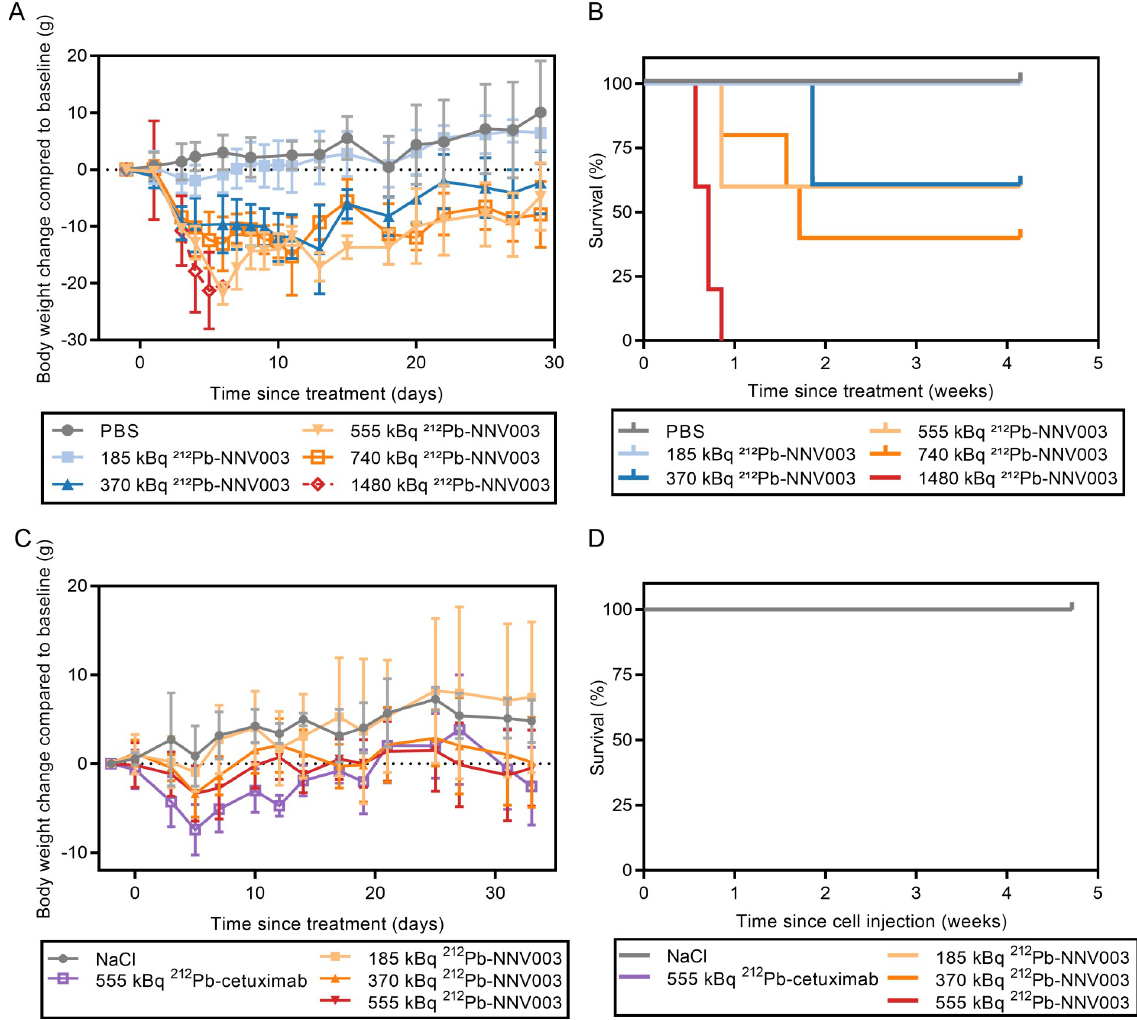
Fig 4. Acute toxicity of 212 Pb-NNV003. CB17 SCIDs were injected i.v. with increasing dose of 212 Pb-NNV003 or PBS. (A) Body weights (average of n = 5, error bars = SD) and (B) survival of the mice. R2G2 mice were injected with increasing dose of 212 Pb-NNV003 (n = 5), 212 Pb- cetuximab or NaCl (n = 3). (C) Body weight (average with error bars = SD) and (D) survival of the mice (overlapping